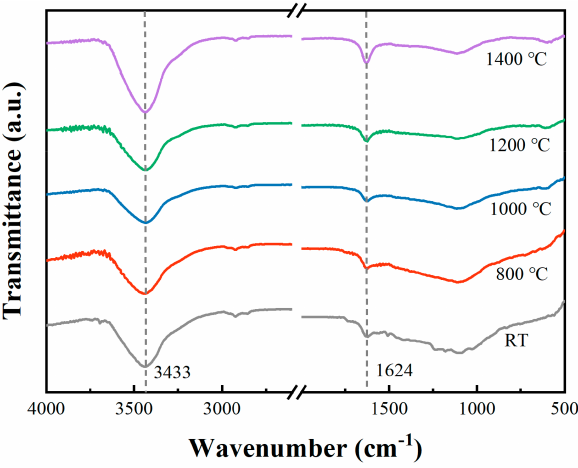
Figure 8. FT-IR spectra of carbon